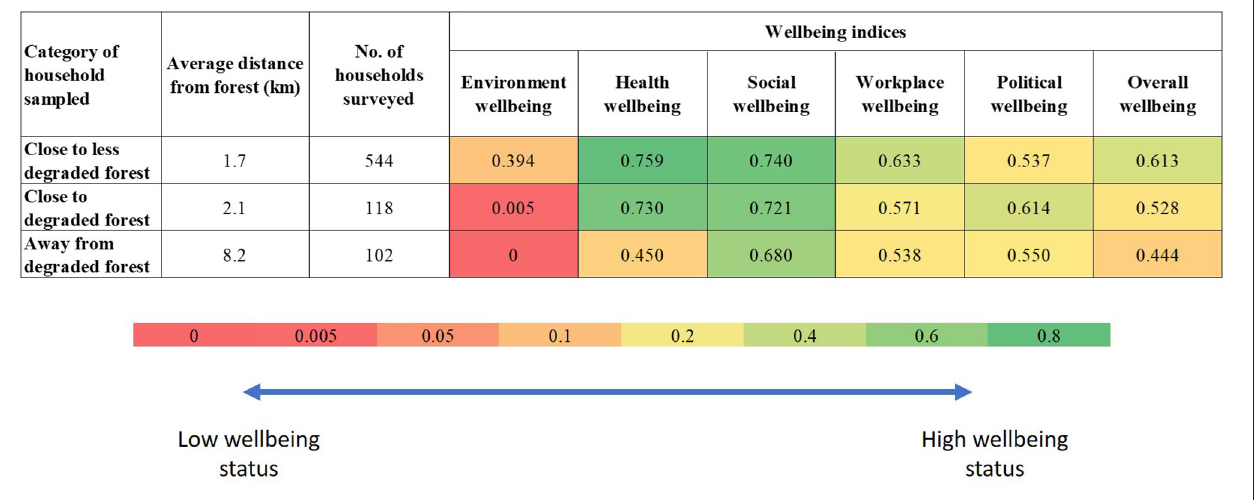
FIGURE 3 | Links between the flow of ecosystem services and human wellbeing under different forest condition